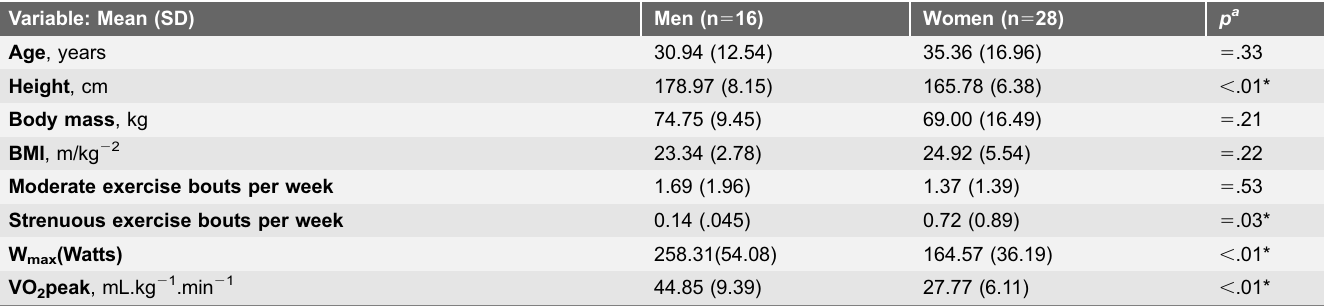
Table 1. Demographic characteristics of participants (n 5